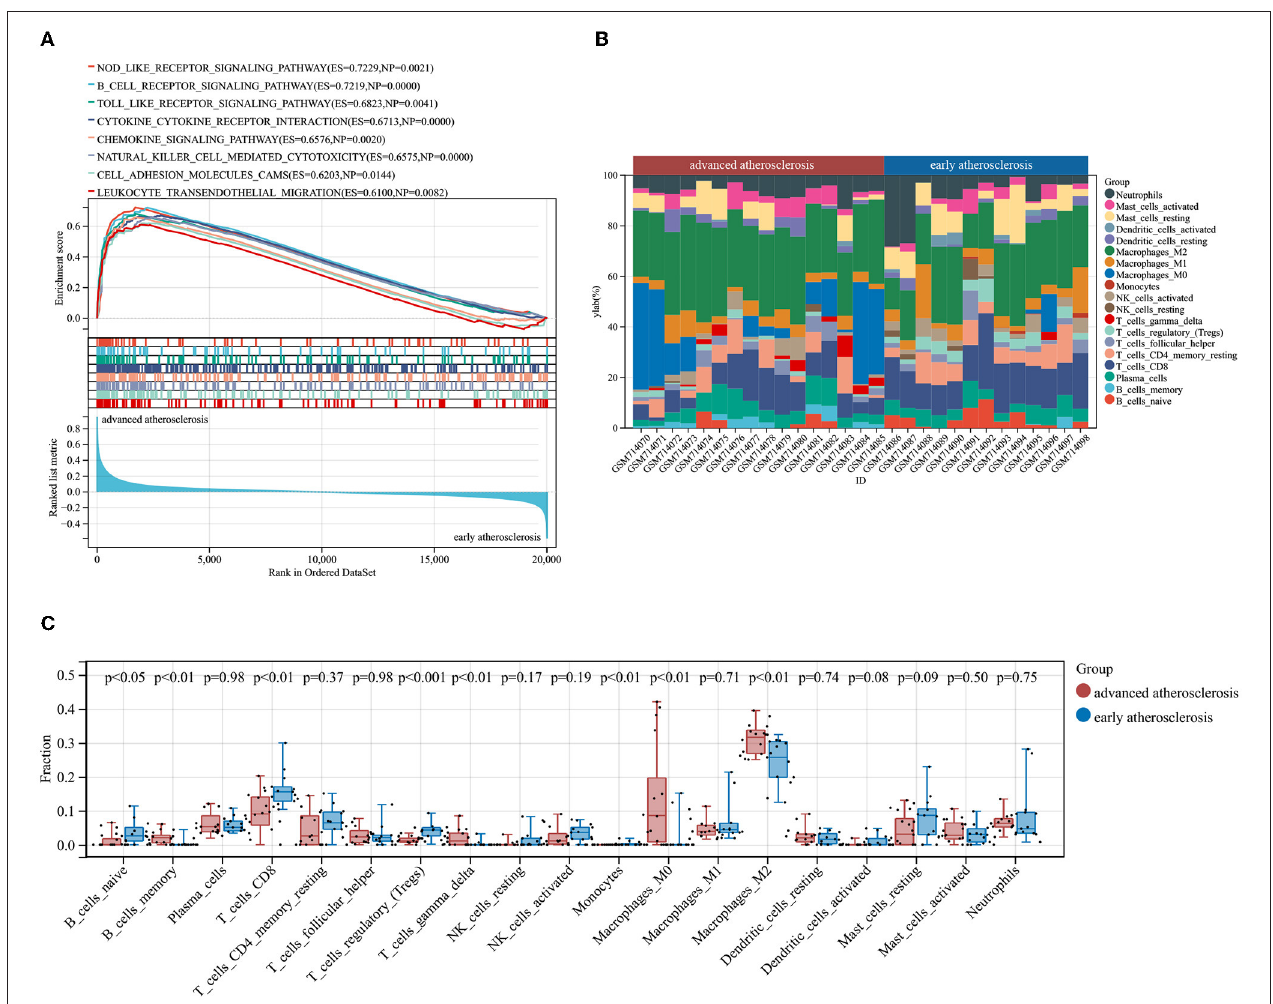
FIGURE 2 | Results of GSEA and CIBERSORTx analysis of GSE28829. (A) Enriched KEGG pathways in advanced atherosclerosis. ES, enrichment score; NP, nominal p -value. (B) The immune cells landscape of the samples in GSE28829. (C) The alterations of infiltrating immune cells between early and advanced